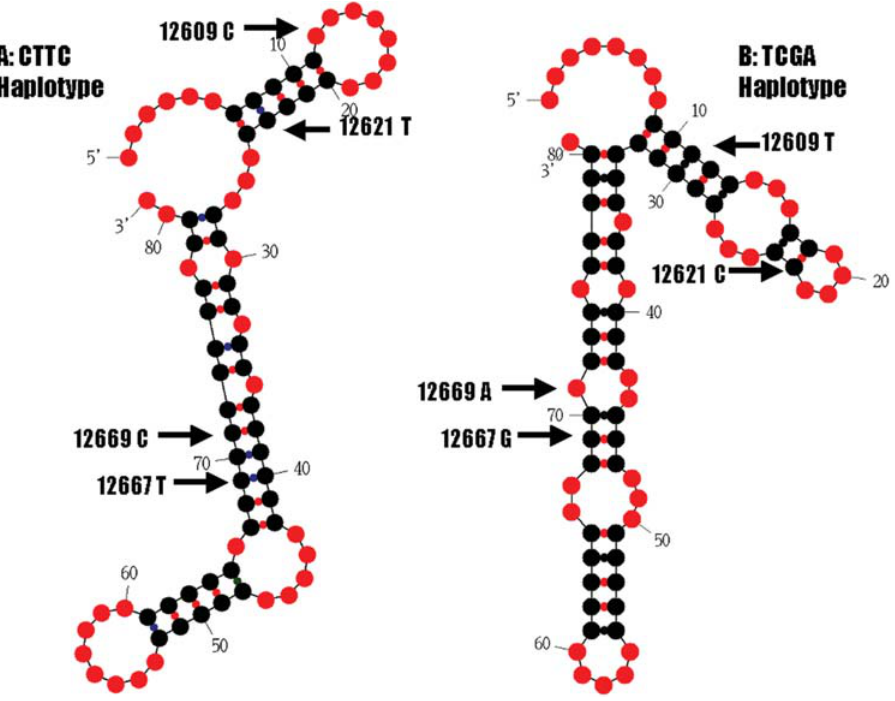
Figure 4. UCN3 mRNA secondary structure predicted by Mfold on a partial sequence of 81 bp surrounding four coding SNPs. A: mRNA secondary structure for haplotype CTTC . B: mRNA secondary structure for haplotype TCGA .